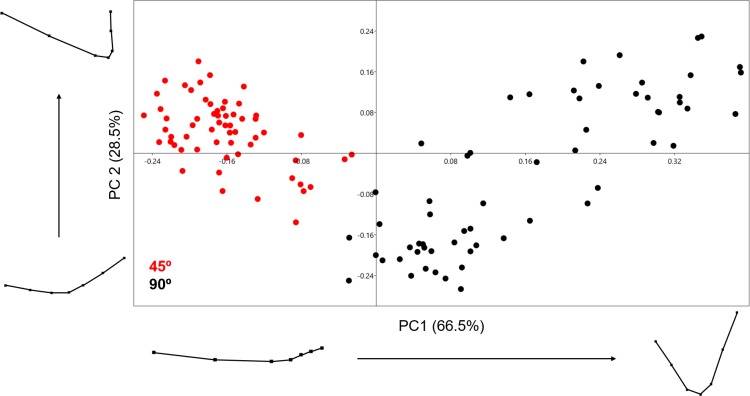
PCA graph presenting variance in cut mark cross-section shape using the 7-landmark model.Variance in shape is presented for the extremities of both PC scores along their respected axis.